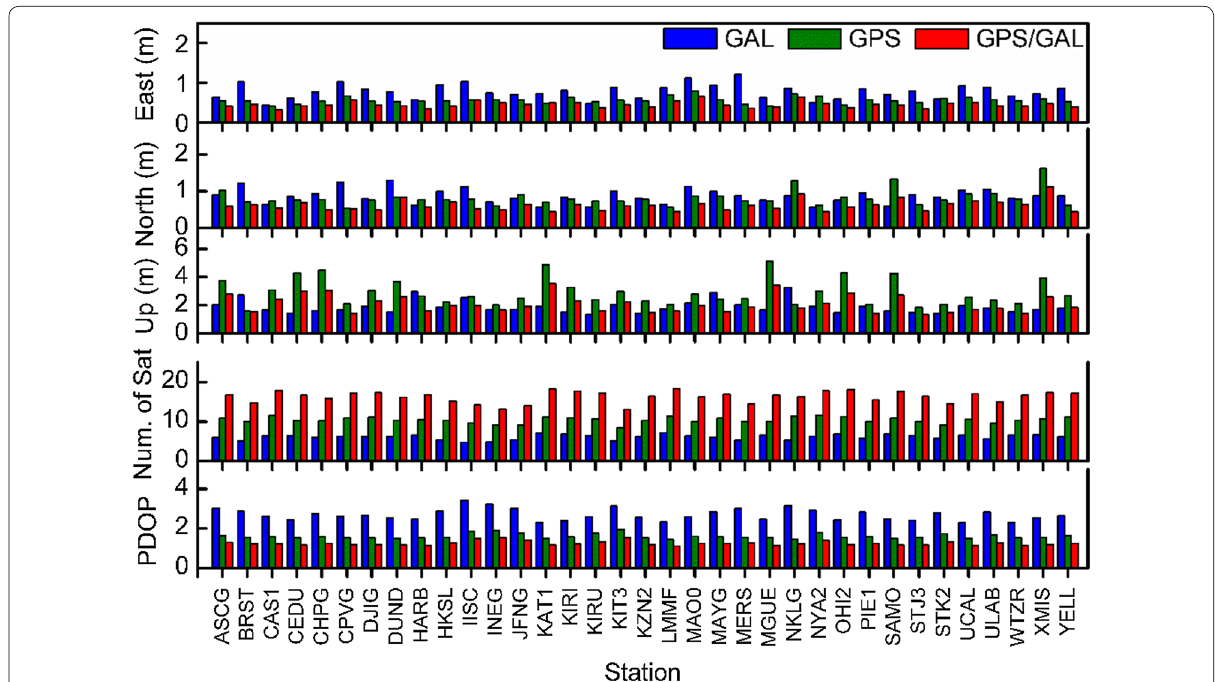
Fig. 11 RMS statistics of positioning errors, average number of satellites and PDOP at 35 stations during DOY 200–206 of